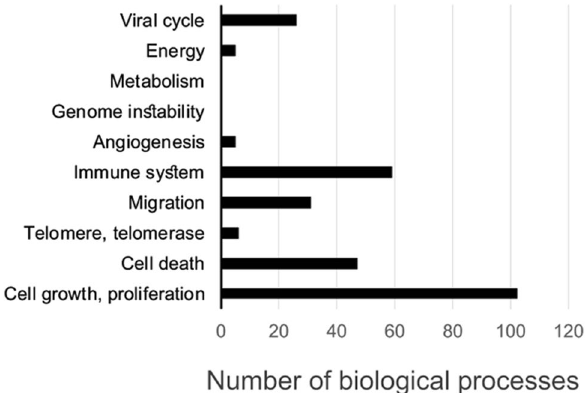
Figure 2. Biological processes affected by COVID-19. The graph shows numbers of biological processes identified in the COVID-19 network. Search of the network was performed for all cancer hallmarks, as described in the text. A complete list of the retrieved biological processes is presented in Supplementary Table S2. The BiNGO network can be explored by using the “Main merged Network BiNGO” in the Cytoscape Session file (Supplementary File S1 at https ://figsh are.com/artic les/onlin e_resou rce/Cance r_and_COVID -19_ syste ms_biolo gy_Suppl _File_S1/12793 883).